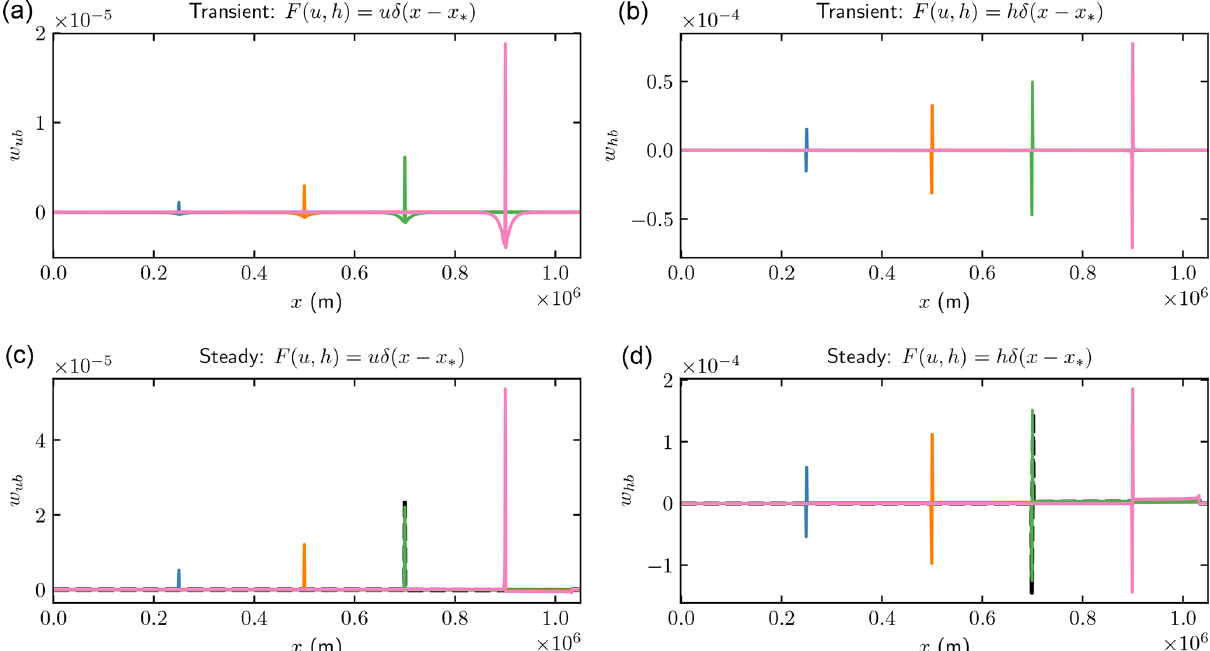
Figure 7. Comparison of the weights w ub and w hb for SSA in Eq. (19) for perturbations δb at different observation points x ∗ = 0 . 25 × 10 6 , 0 . 5 × 10 6 , 0 . 7 × 10 6 , and 0 . 9 × 10 6 (blue, orange, green, and pink). The dashed black lines in (c, d) are the weights of δb in Eqs. (A3) and (A5) at x ∗ = 0 . 7 × 10 6 . (a, b) Transient simulations; (c, d) steady states. (a, c) w ub for pointwise u response; (b, d) w hb for pointwise h response.